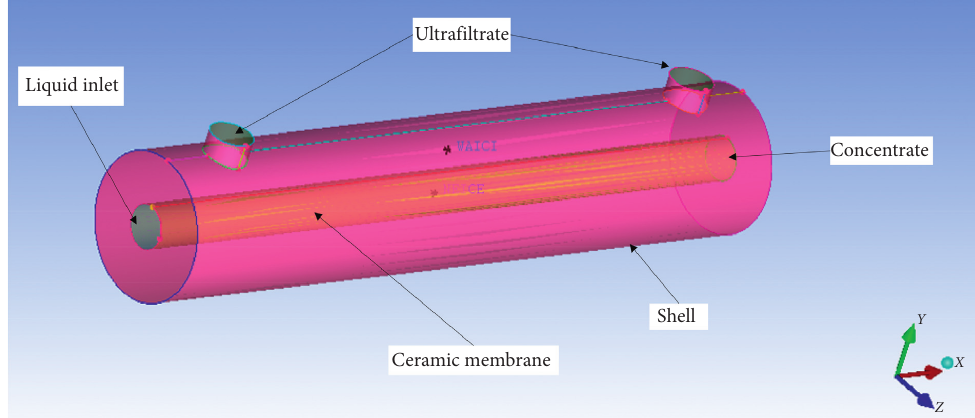
Figure 3: Tubular MBR geometry model.